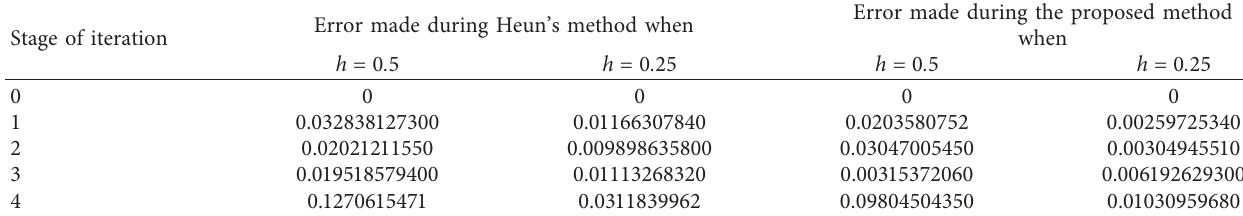
Table 6: Errors made by the stated numerical methods for Example